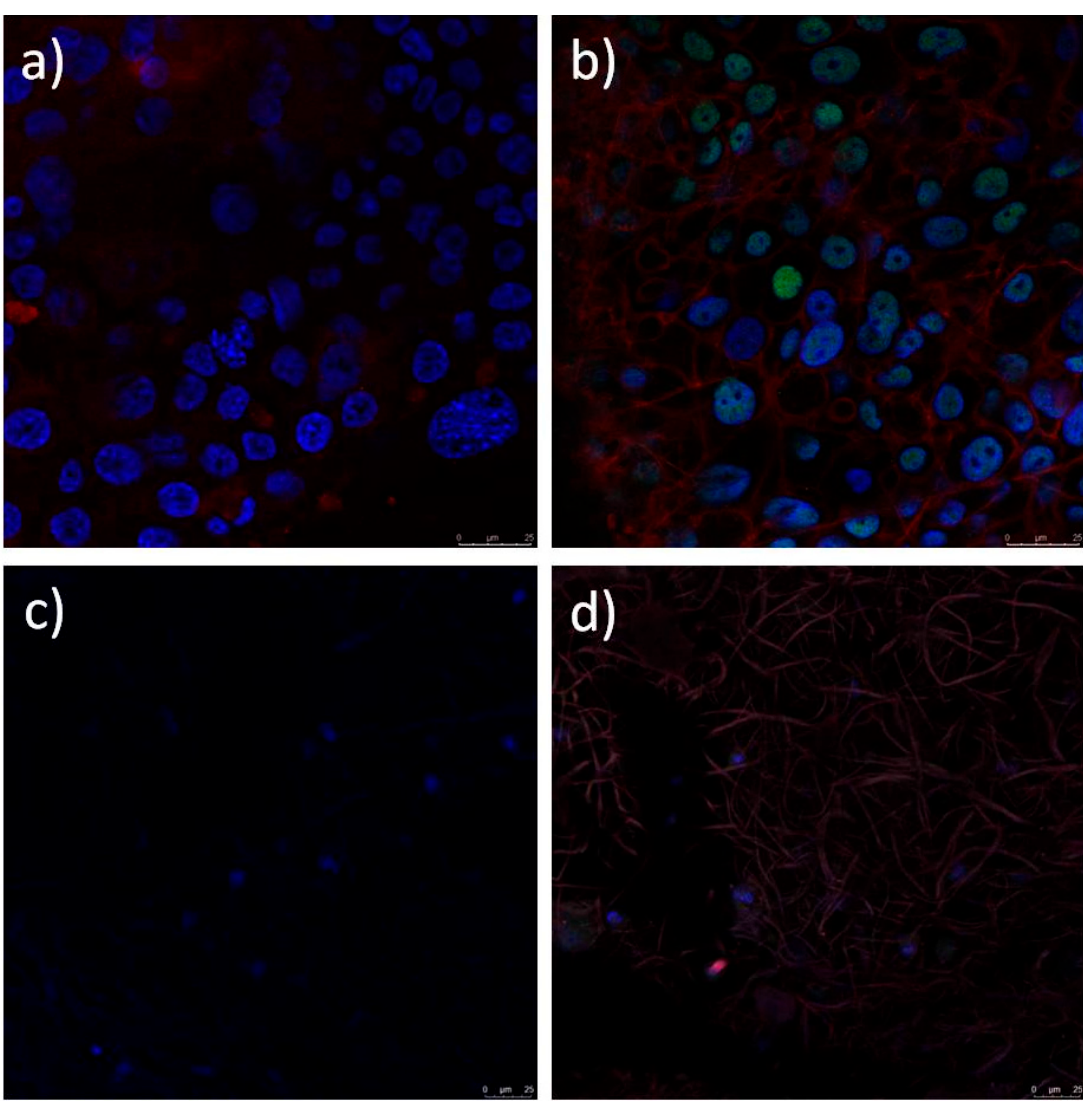
Figure 17. Immunofluorescence analysis of limbal stem cells cultured on PCL/5 wt % CF ( a , b ) and PCL/25 wt % CF ( c , d ) scaffold. Cells stained against cornea marker CK3 have cytoplasm coloured red ( a , c ). Cell stained against stem cell marker p63 show nuclei stained with turquoise. Cytoskeleton is stained red with phalloidin-tetramethylrhodamine B isothiocyanate (TRITC) ( b , d ). All nuclei are counterstained with blue stain 4 ′ ,6-diamidino-2-phenylindole (DAPI).